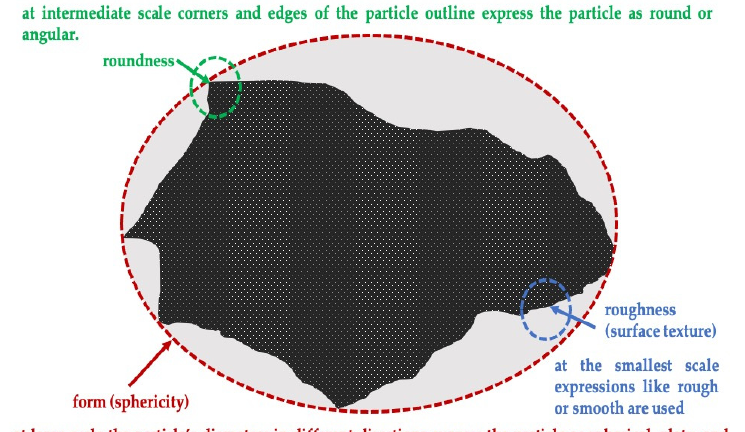
Figure 8. Description of a particle morphology based on three different scales (modified from [50,56,60,61]).